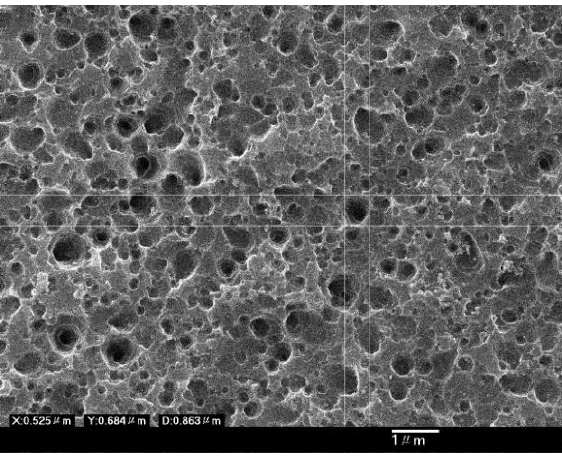
Figure 3. SEM image of the macroporous Si surface after RIE process and removal of the alumina